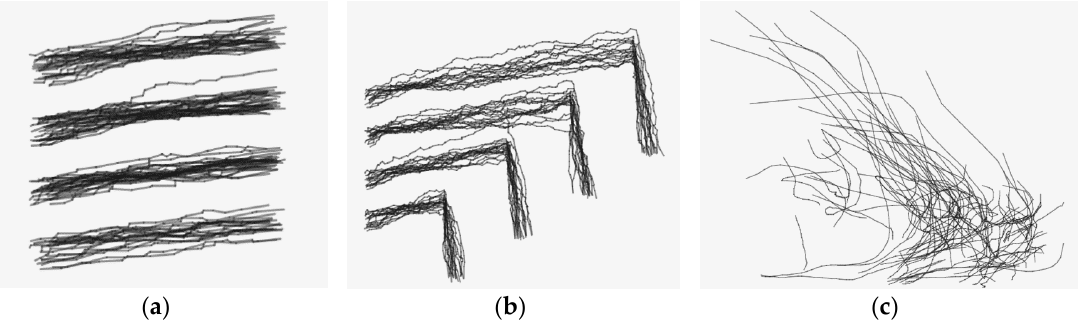
Figure 6. The trajectory in the RT and HT datasets. ( a ) RT1; ( b ) RT2; and ( c ) HT.